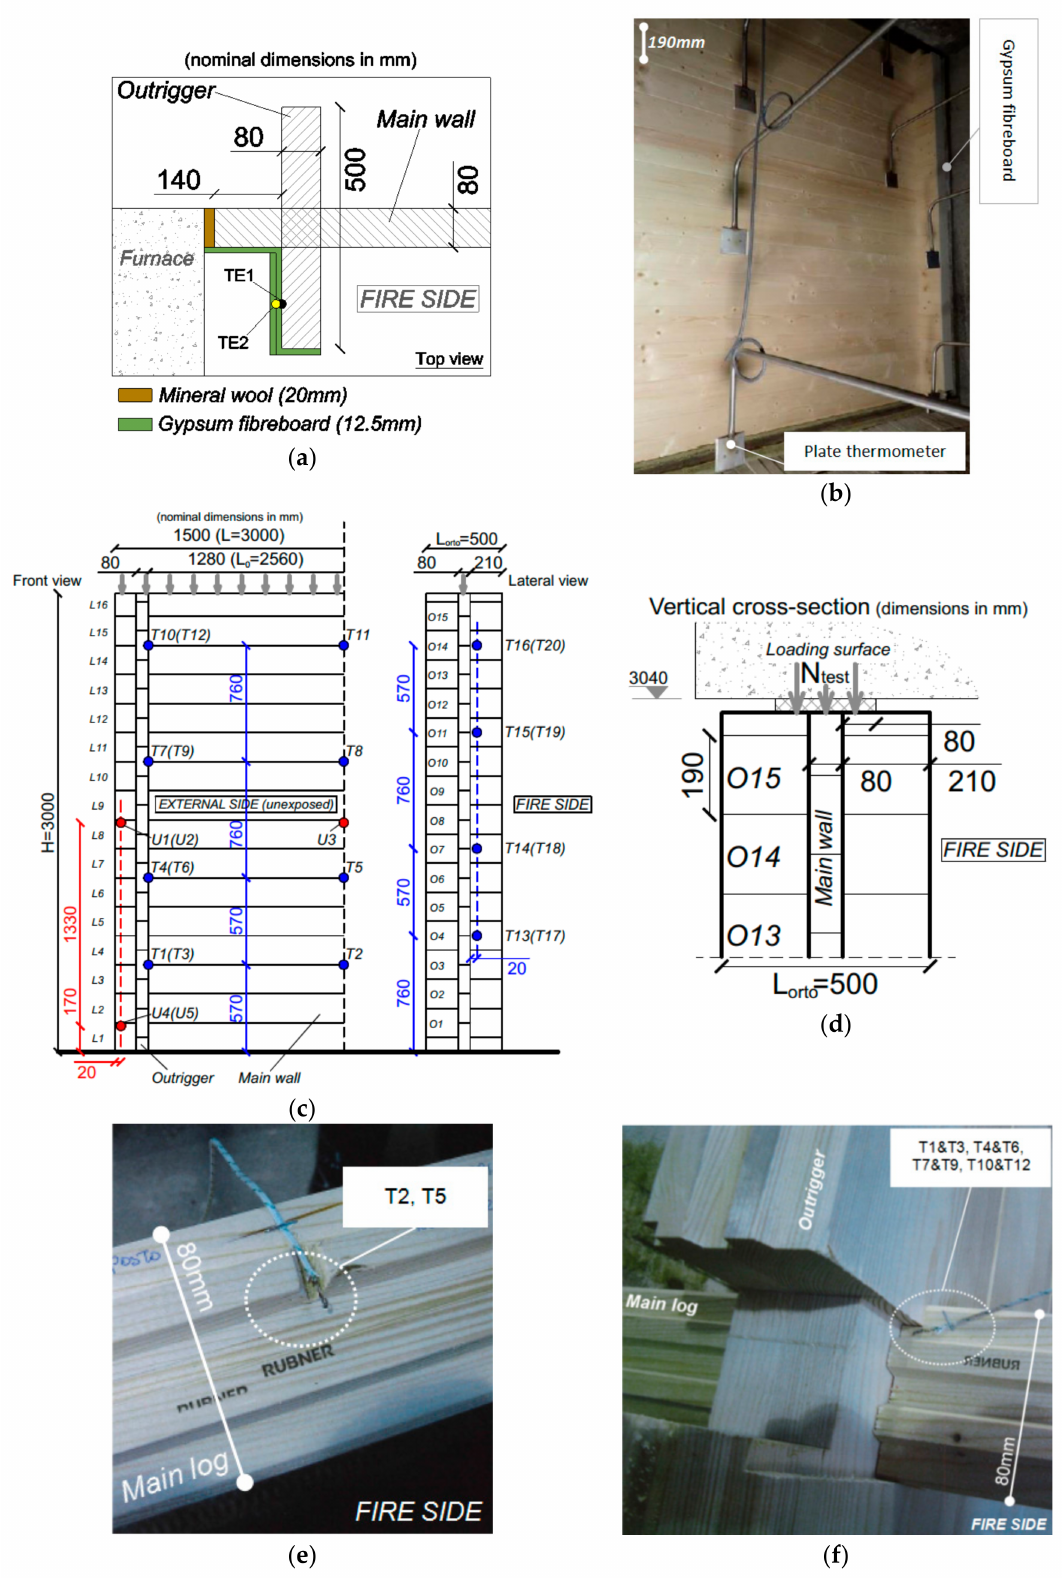
Figure 2. W80 fire test: ( a ) thermal insulation of outriggers (top view, cross-sectional detail at an height of 0.5 H = 1500 mm from the ground); ( b ) plate thermometers within the furnace; ( c ) mechanical loading and instrumentation layout (in brackets, the labels for the symmetrical instruments); with ( d ) schematic cross-section of the compressed region; ( e , f ) Top view photos of the positioning detailing of selected